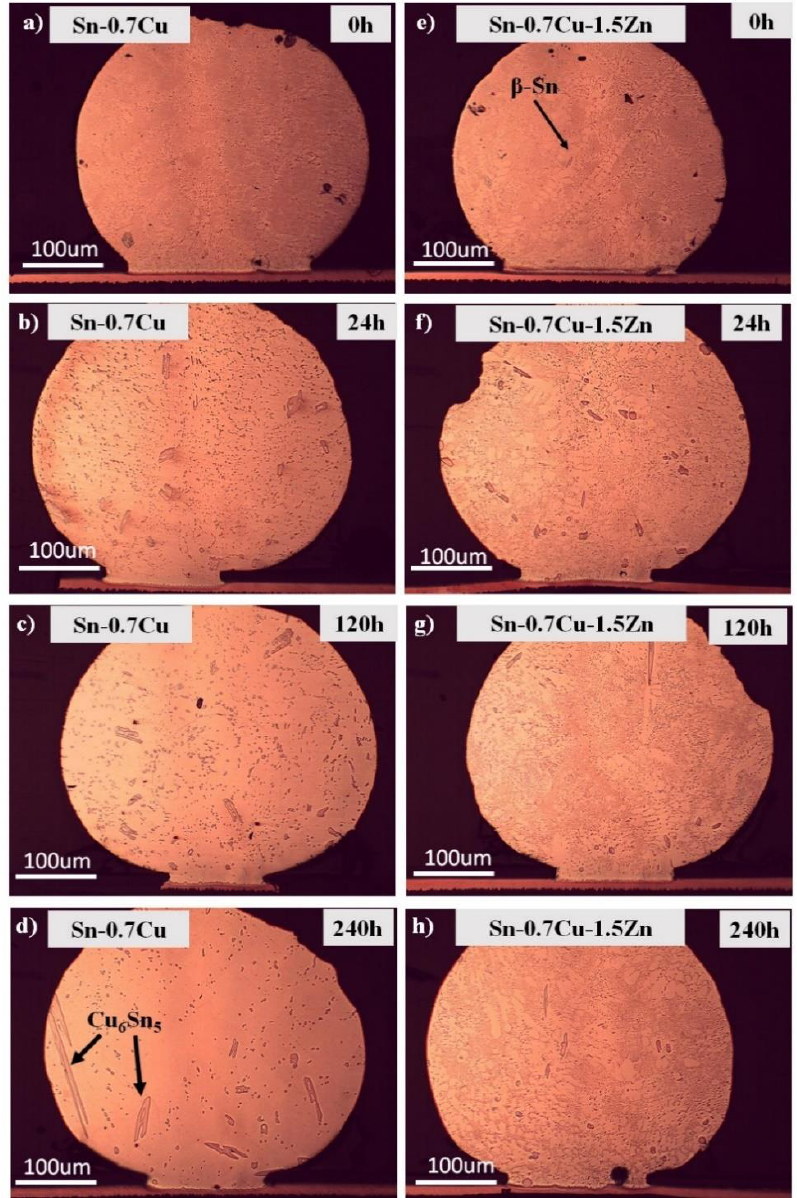
Figure 4. Microstructure of primary IMC after annealing at 180 °C. Sn-0.7Cu at ( a ) 0 h, ( b ) 24 h, ( c ) 120 h, ( d ) 240 h and Sn-0.7Cu-1.5Zn at ( e ) 0 h, ( f ) 24, h ( g ) 120 h, ( h ) 240 h.